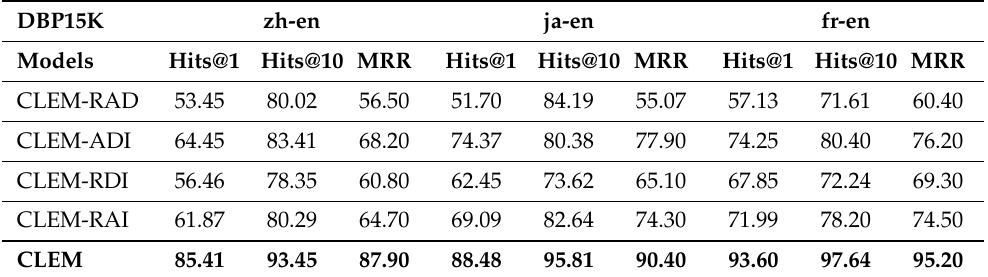
Table 4. The comparison results of CLEM and its variants in the ablation